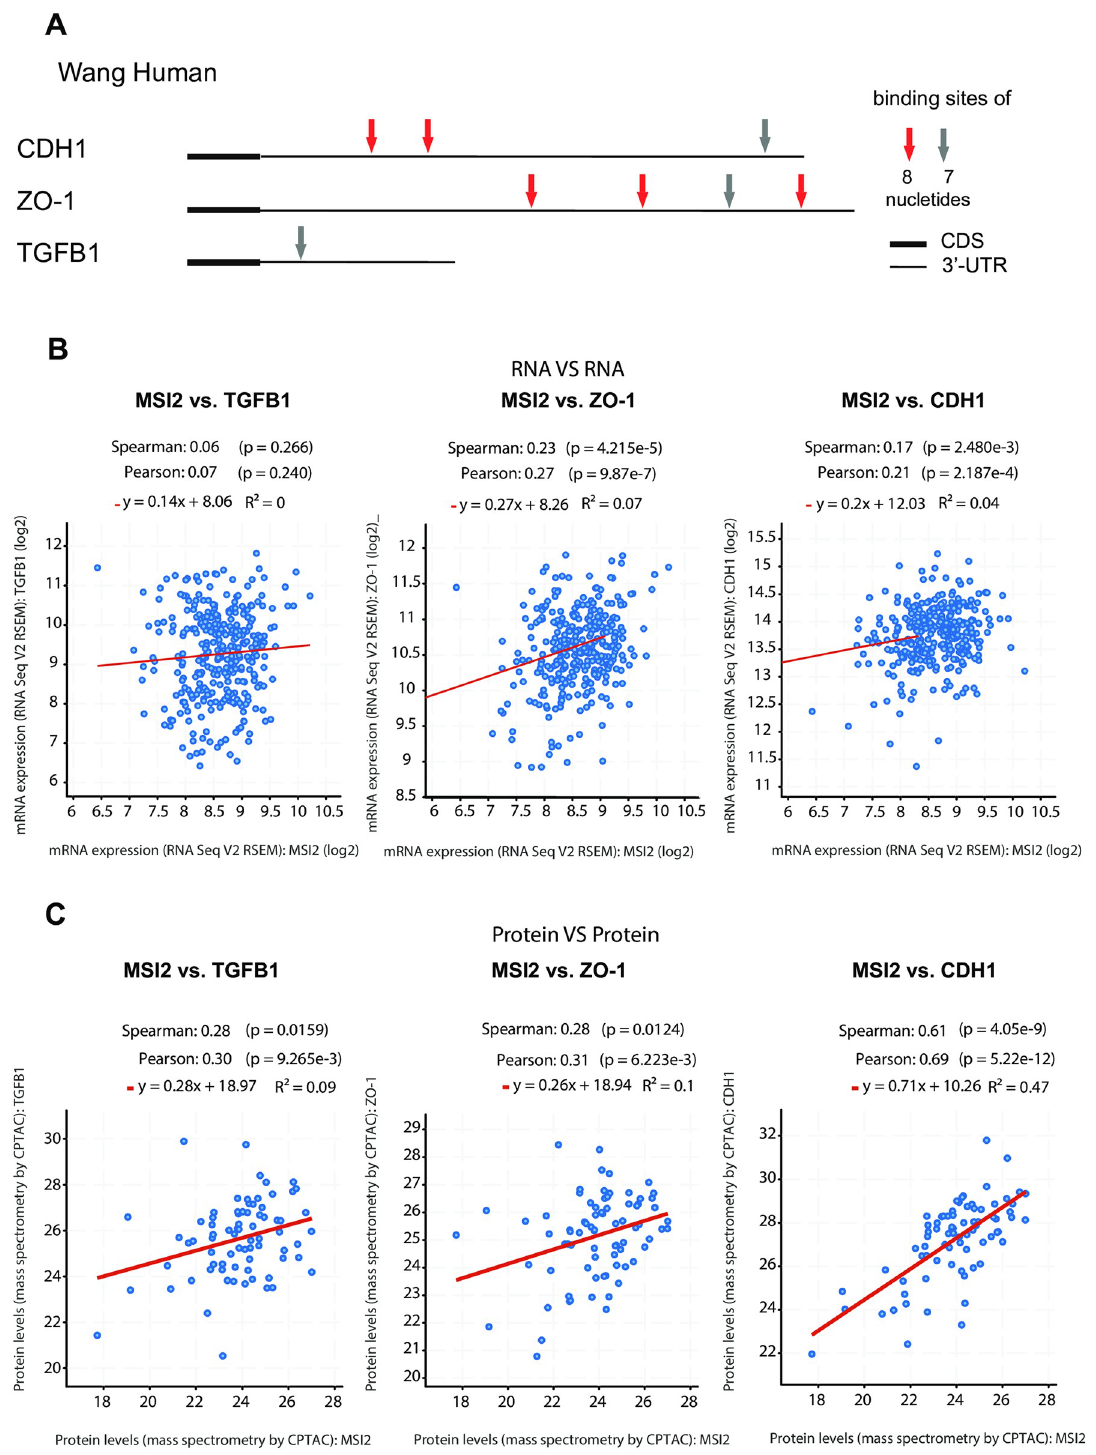
Fig 3. In silico analysis of MSI2 gene regulation in CRC. ( A ) Location of predicted binding sites for human MSI2 protein defined from study by Wang et al . [25], using eight MSI2 binding motifs with the highest p values). Coding sequences (CDS) are represented by thick lines; 3’ untranslated regions (3’UTR) by thin line. Shorter consensus sequences are not indicated. ( B, C ) Correlation analysis for expression between MSI2 and CDH1, TGF β 1, ZO1, based on 203 CRC mRNA specimens ( B ) or 83 CRC protein specimens ( C ), based on data downloaded from www.cbioportal.org (TCGA, Firehouse legacy, Date: January 22 2020).